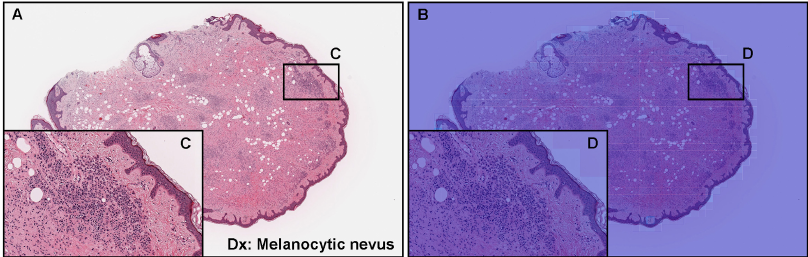
Figure 5. An example of true negative predictions of melanoma using the × 20, 512 × 512 px model. According to the histopathological diagnostic (Dx) report, ( A ) was diagnosed as melanocytic nevus according to the representative morphology ( C ). The heatmap images ( B , D ) show true negative predictions of melanoma cells. Red indicates a high probability and blue indicates a low probability.